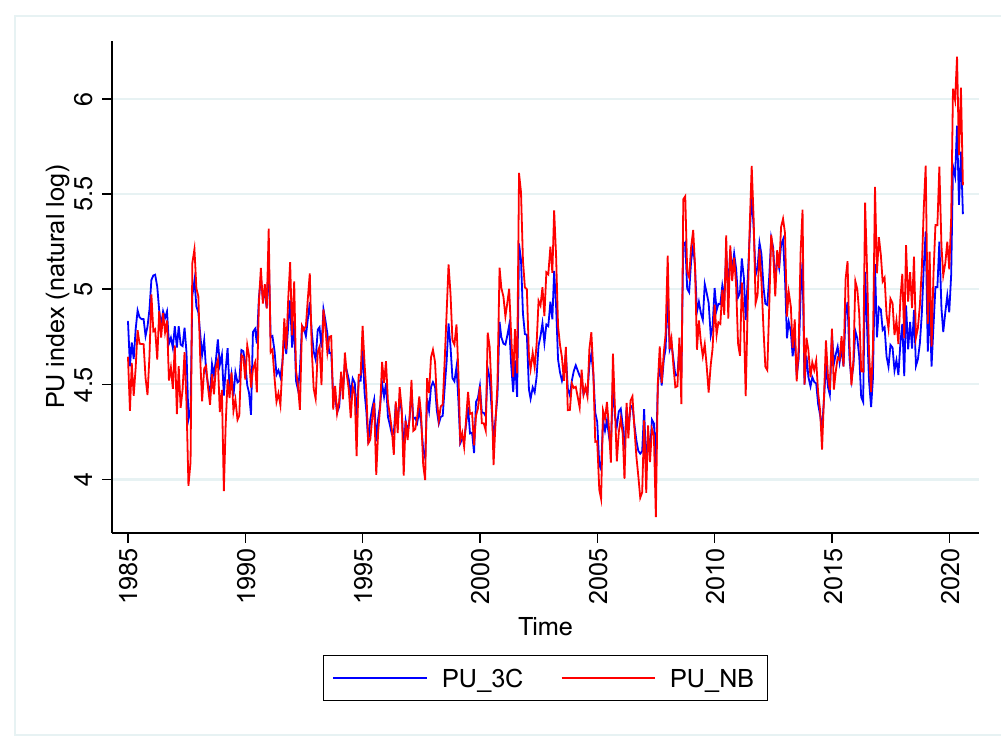
Figure 2. US monthly policy uncertainty index. Source: Baker, Bloom, and Davis [12].